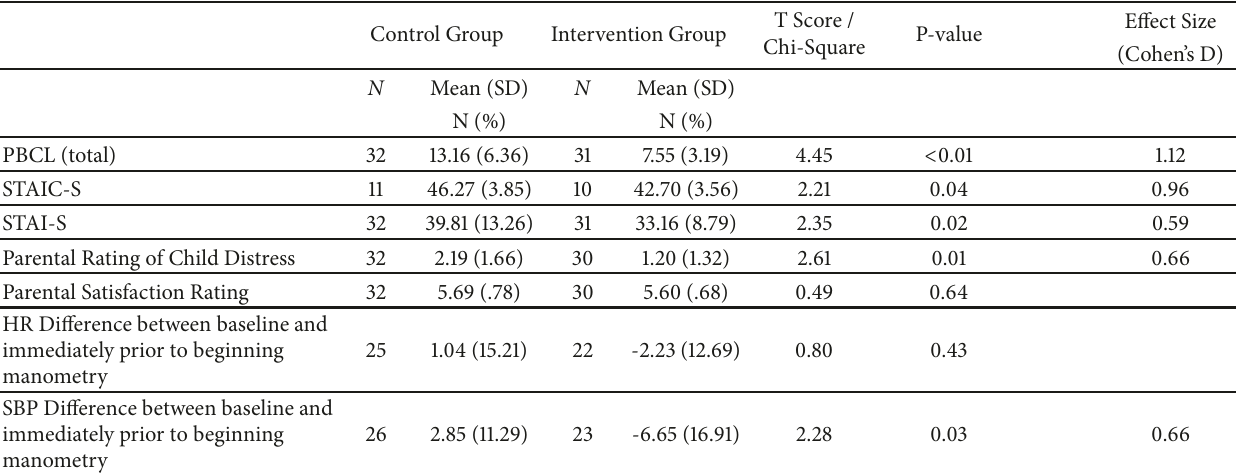
Table 2: Comparison of intervention to control